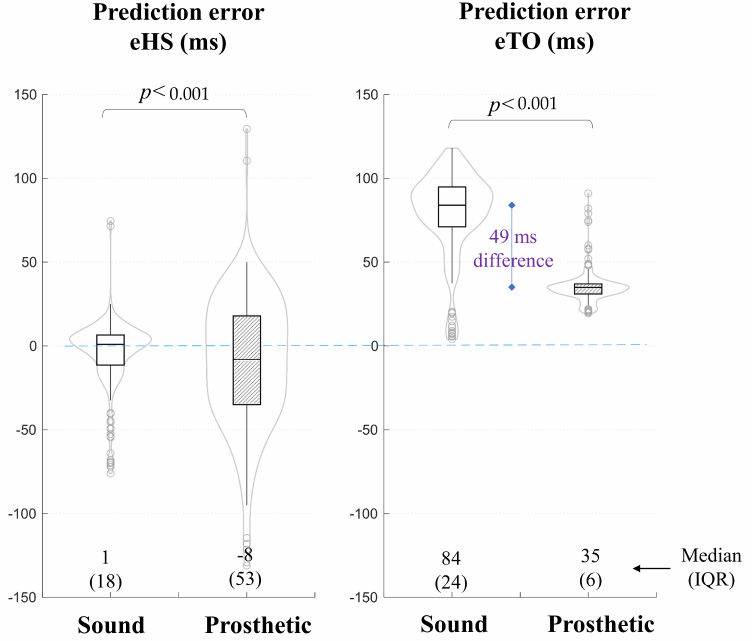
Figure 3. Separate boxplots and error distribution for sound and prosthetic legs. Median and interquartile ranges are presented at the bottom in each case. Significant differences were found between errors on the sound and prosthetic